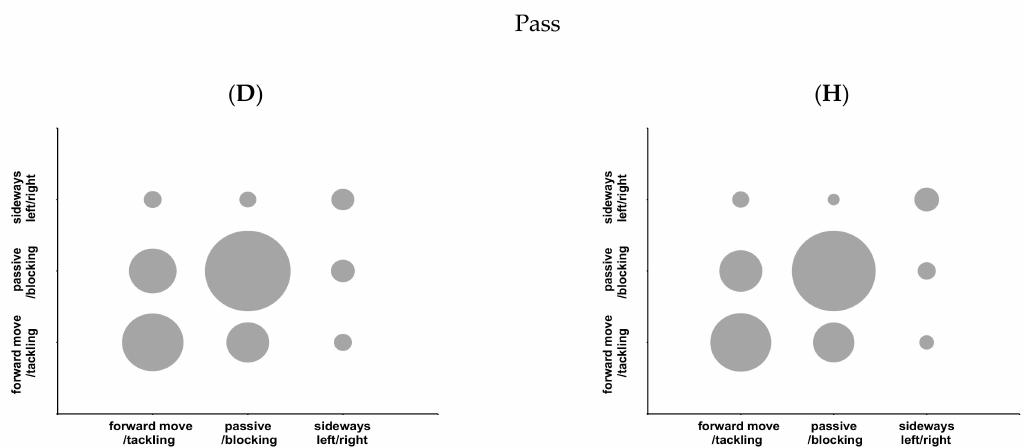
Figure 5. Intra-session response distribution and frequency of choices of motor response within video pairs. Bubbles show participants’ response agreement between first ( x -axis) and second video ( y -axis) responses for all attack actions (sideways left and right as aggregates). Bubble distributions for the right-handed ( A – D ) and left-handed ( E – H ) attacks illustrate the response consistency, and bubble sizes represent the frequencies of participants’ responses. Large bubbles indicate more agreement; small bubbles indicate less agreement. Table 1. Intra-session agreement of the CoMR for all right and left-handed attacks. Agreement between video pairs ( n ) for each occlusion of an attack (session 1) was assessed using Cohen’s kappa ( K ). The 95% confidence interval (CI) and significance values ( p ) were calculated. Right-Handed Attacks Left-Handed